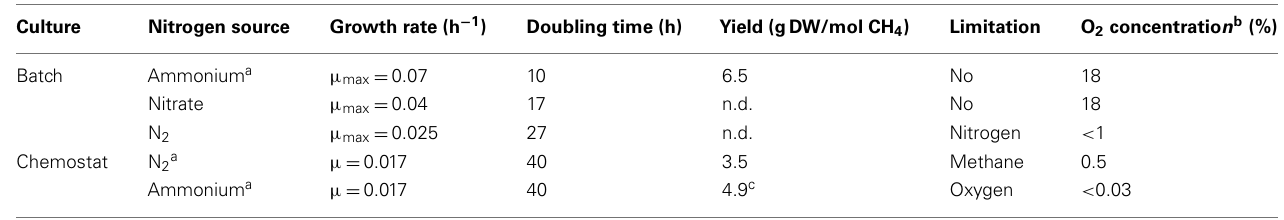
Table 1 | Description of batch and chemostat cultures of “ Ca. Methylacidiphilum fumariolicum ”